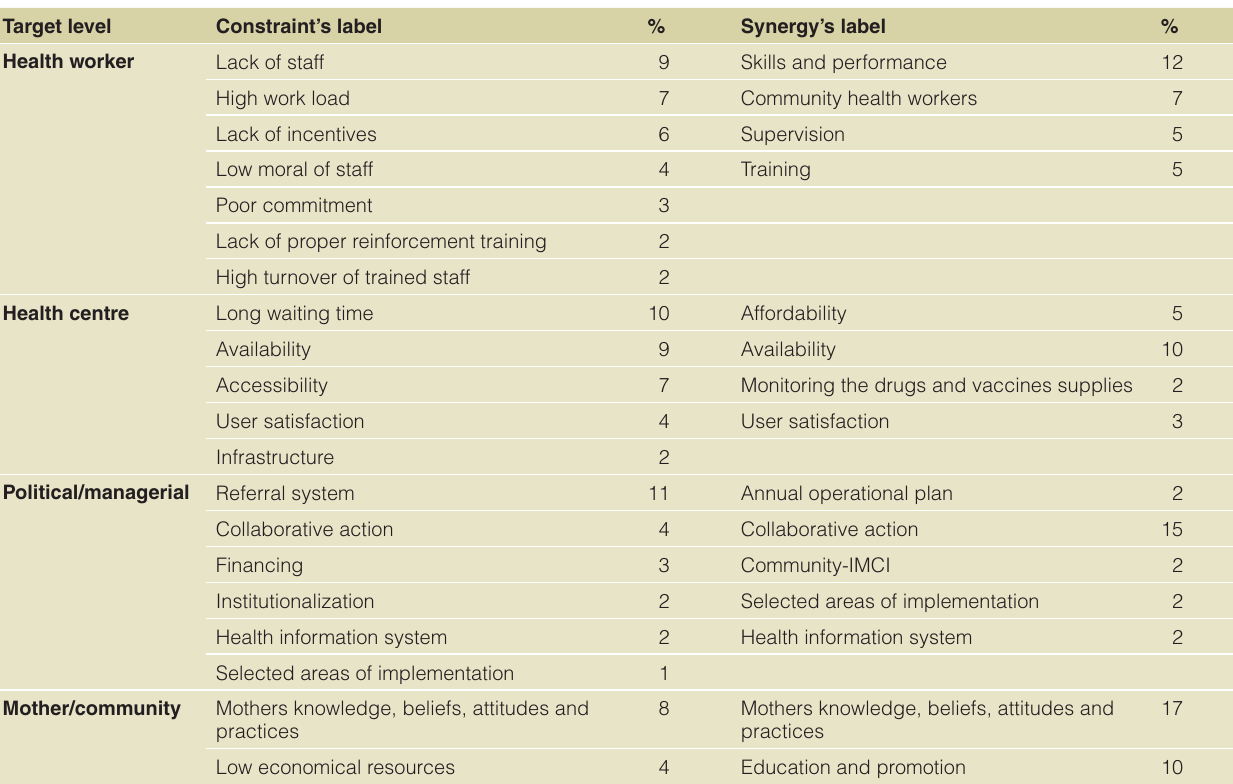
Table 4. Classification of identified integrated management of childhood illness (IMCI)-related constraints and synergies according to their target level and label together with the percentage of respondents that agreed with each label. Target level